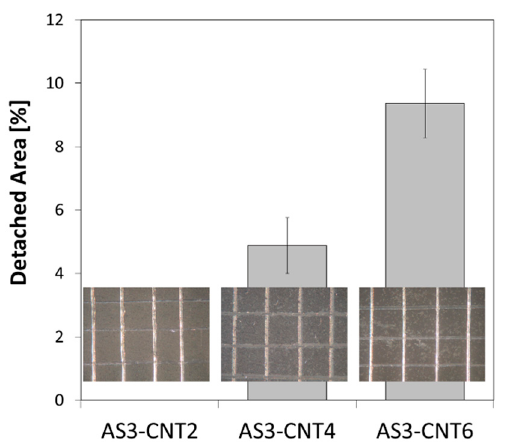
Figure 4. Detached area, observed after tape peel test, of silane-based coatings at increasing CNT filler content (three replicates for each coating).